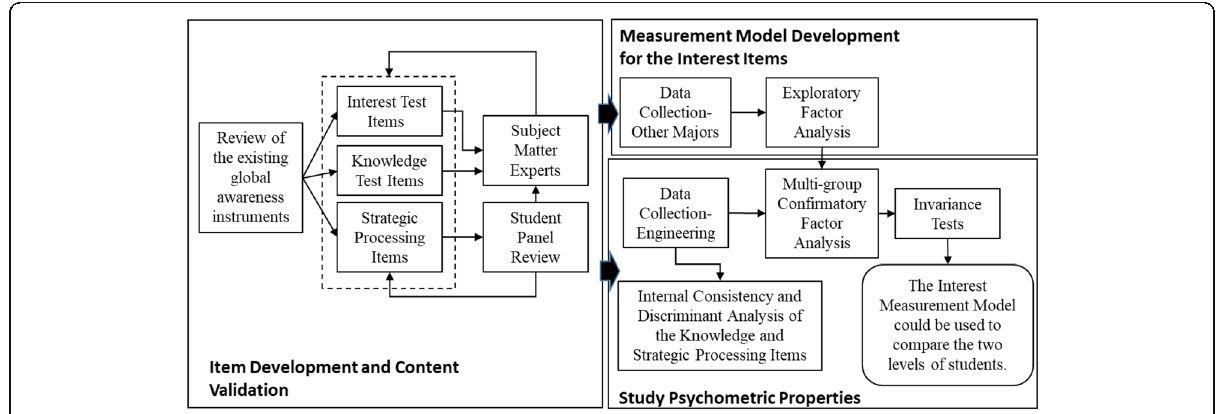
Fig. 1 The research process of the instrument development and